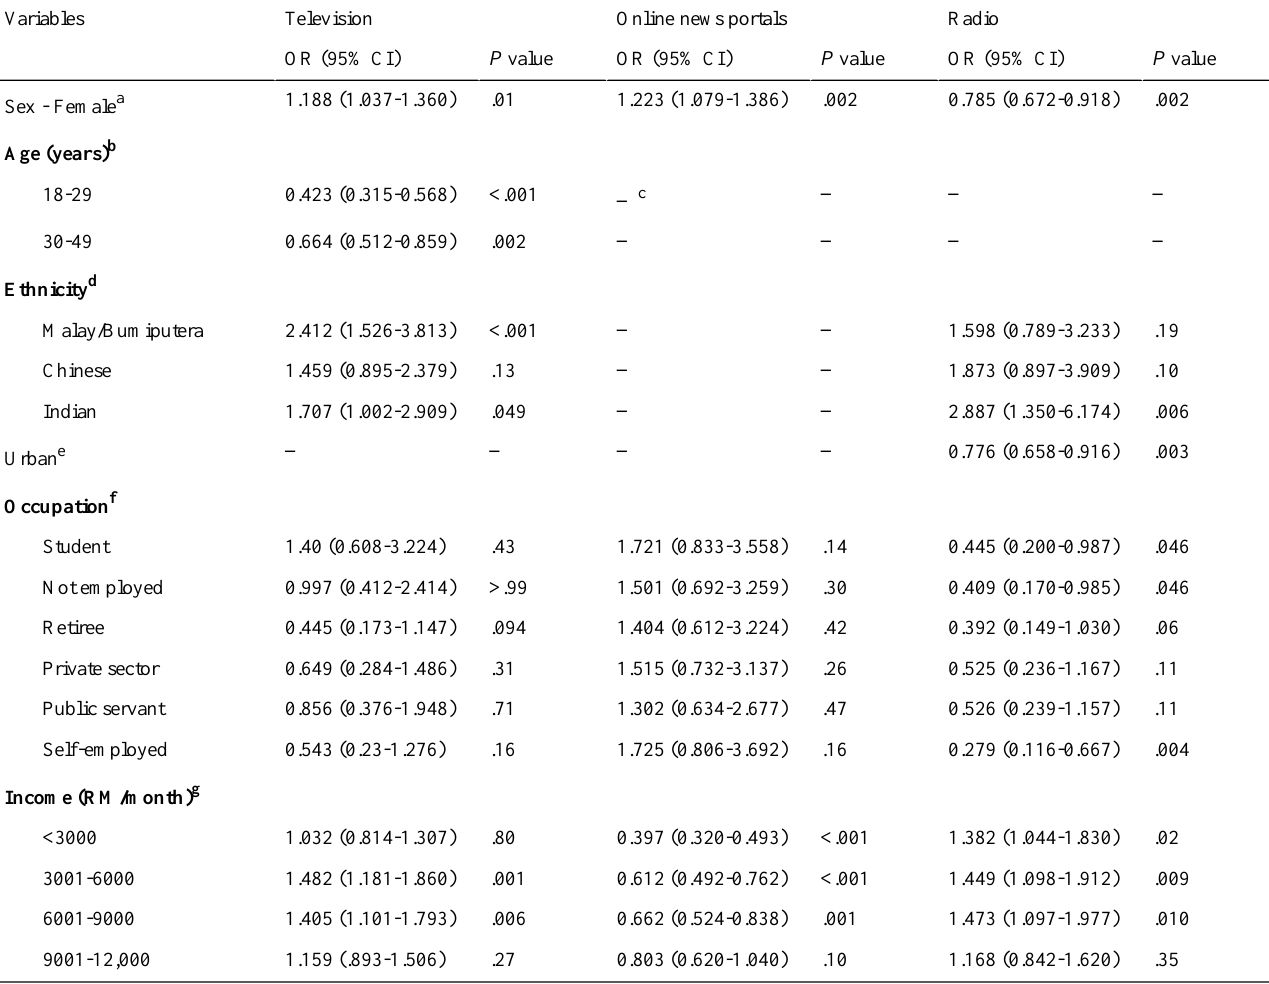
Table 2. Factors related to the use of COVID-19 mass media information sources.